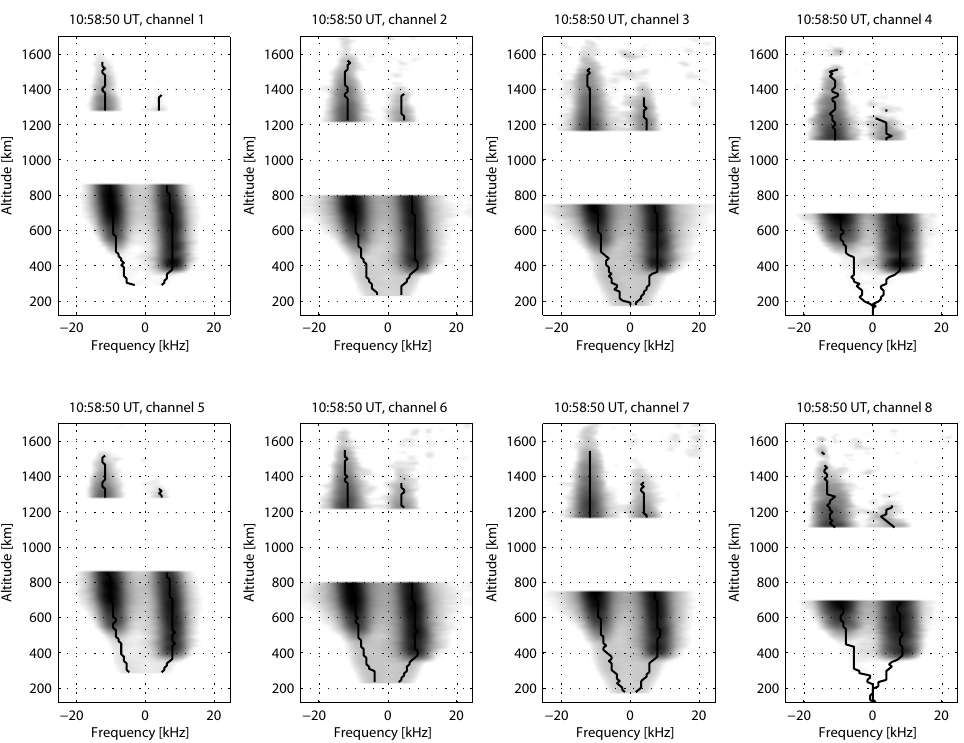
Fig. 2. Naturally enhanced ion-acoustic lines (NEIALs) observed with the ESR 32m antenna at 10:58:50 UT on 28 July 2000. Power spectra from channel 1 to channel 8 are plotted with a gray scale, over frequency on the x axis and range on the y axis. The black lines follow the positions of each of the ion-acoustic